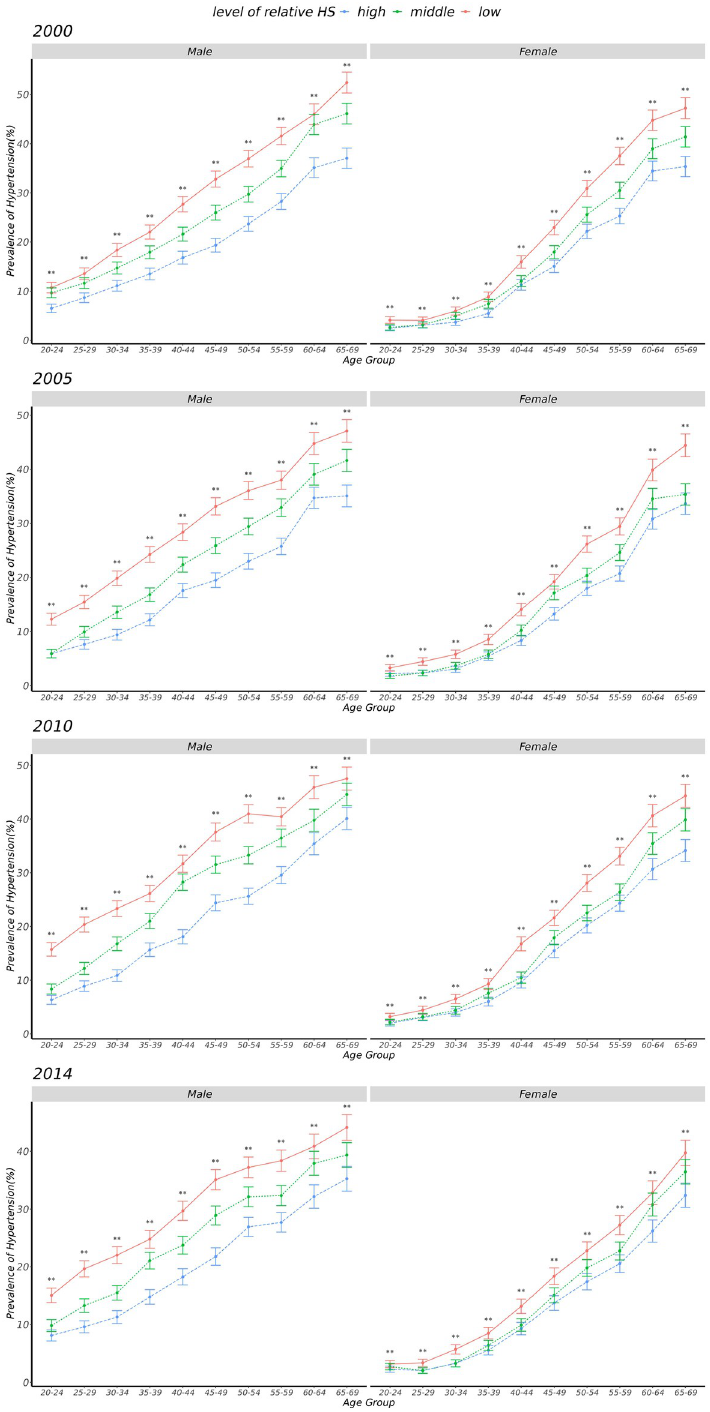
Fig 3. The prevalence of hypertension among three tertile groups of handgrip strength across different age groups in four survey years (error bars represent 95% confidence intervals for medians, �� represent p < 0.001).